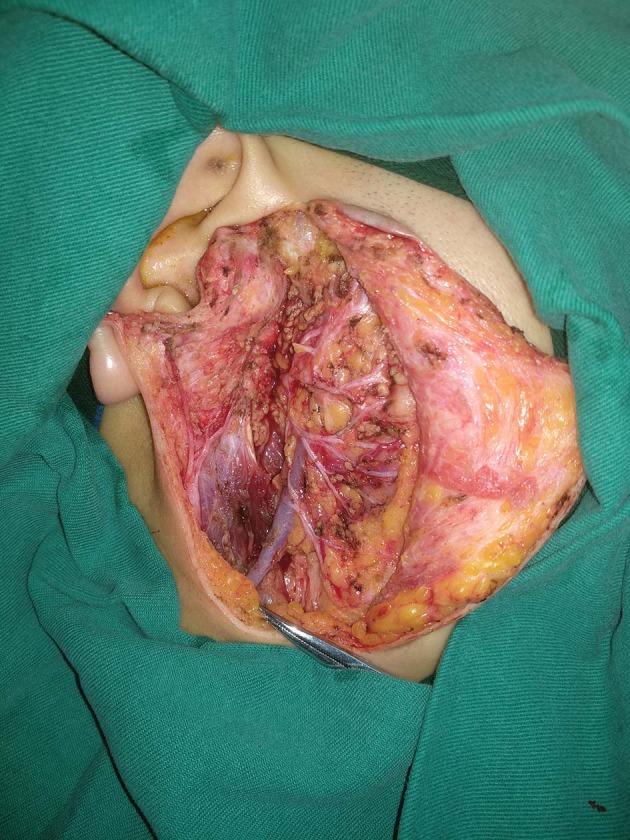
Superficial parotidectomy in a pediatric patient.